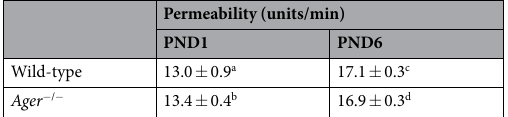
Table 1. Intestinal permeability measured by FITC-dextran. To assess intestinal tissue permeability using a FITC-dextran assay, 4-kDa FITC-dextran was injected into the mucosal side of the isolated intestine as in Fig. 4. Samples were collected at the beginning of incubation and after 3 min. The fluorescence of the samples was quantified by a spectrofluorophotometer (Model RF6000, Shimadzu, Kyoto, Japan): the excitation wavelength was 485 nm, and the emission wavelength was 538 nm. The result obtained at 0 min (arbitrary units) was subtracted from the result obtained at 3 min, and this difference was then divided by 3 min. N = 3 for each genotype. Two-tailed Student t -test: P = 0.67 between a and b; P = 0.59 between c and d; P < 0.01 between a and c; P < 0.002 between b and d,